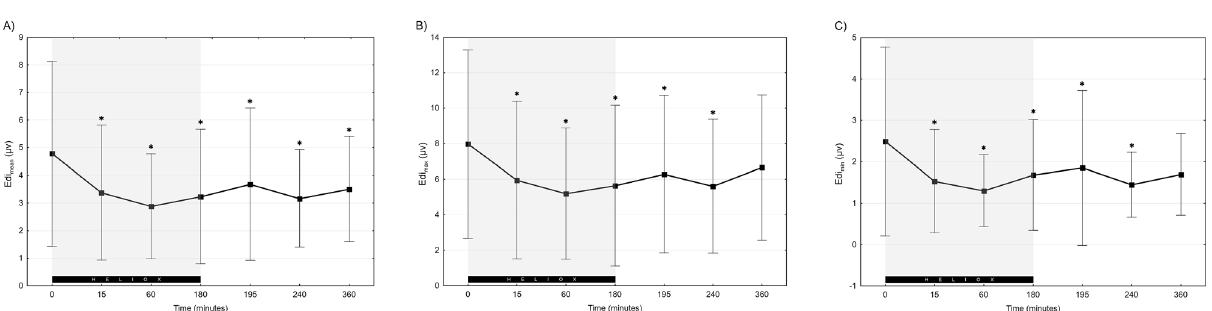
Figure 2. Ventilatory parameters during the study: PIP ( A ), FiO 2 ( B ), RR ( C ). Grey background highlights heliox NIV-NAVA period. Data presented as mean ± SD; *indicates statistically significant changes versus baseline.